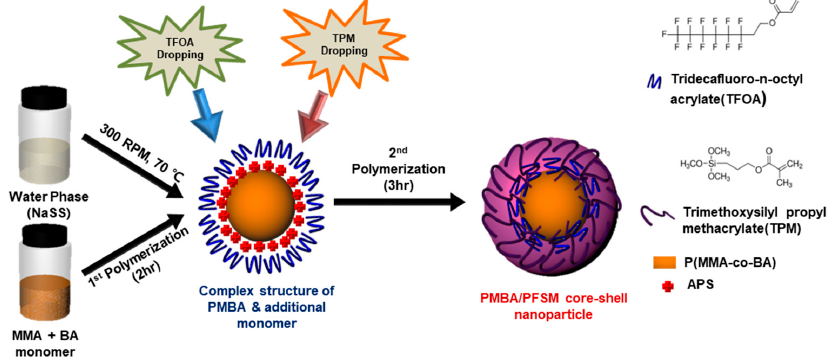
Figure 1. Schematic diagram of the PMBA/PFSM core-shell nanoparticle using the delay addition